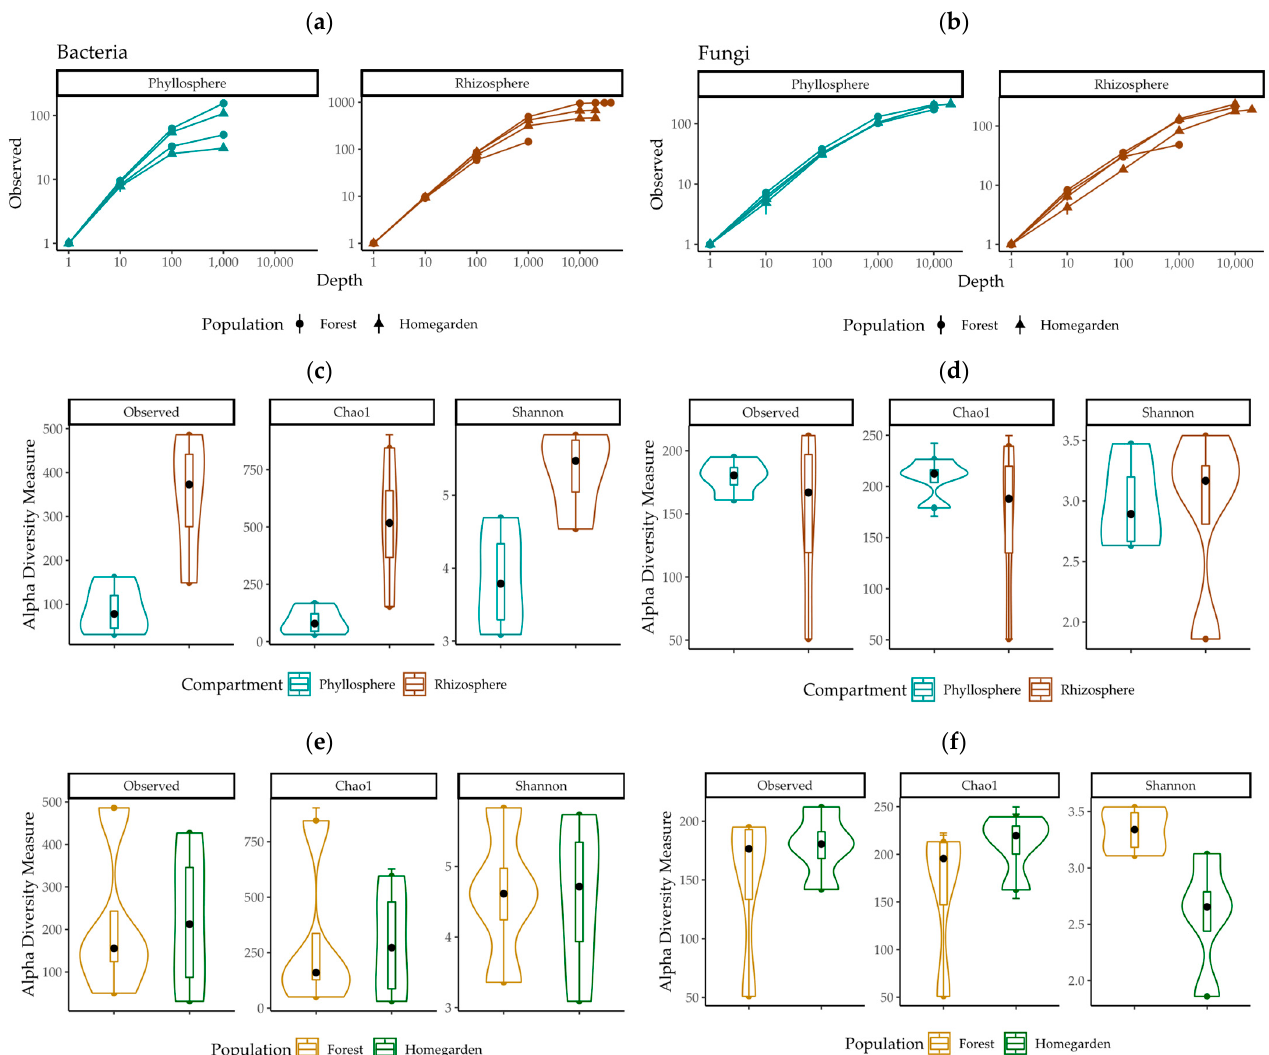
Figure 1 . Rarefaction curves depicting the observed frequency of operating units (OTUs) by the sequencing depth in ( a ) bacteria, ( b ) fungi, and the alpha-diversity measures in ( c , e ) bacteria and ( d , f ) fungi microbiota from ( c , d ) phyllosphere and rhizosphere, in ( e , f ) Yucatán’s forest and homegarden populations of Cordia dodecandra .